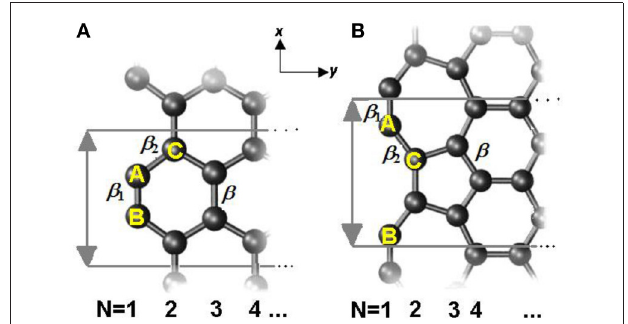
FIGURE 4 | Illustration of structure of (A) AGNR and (B) RecGNR edges. The reconstructed edge consists of 7- and 5-atom rings. Periodic direction is along x axis and ribbon width in y axis. The hopping integrals are indicated as β , β 1, and β 2 . N indicates the counting of ribbon width; the numbers also mark the atomic position. Reprinted with permission from Zhang et al.